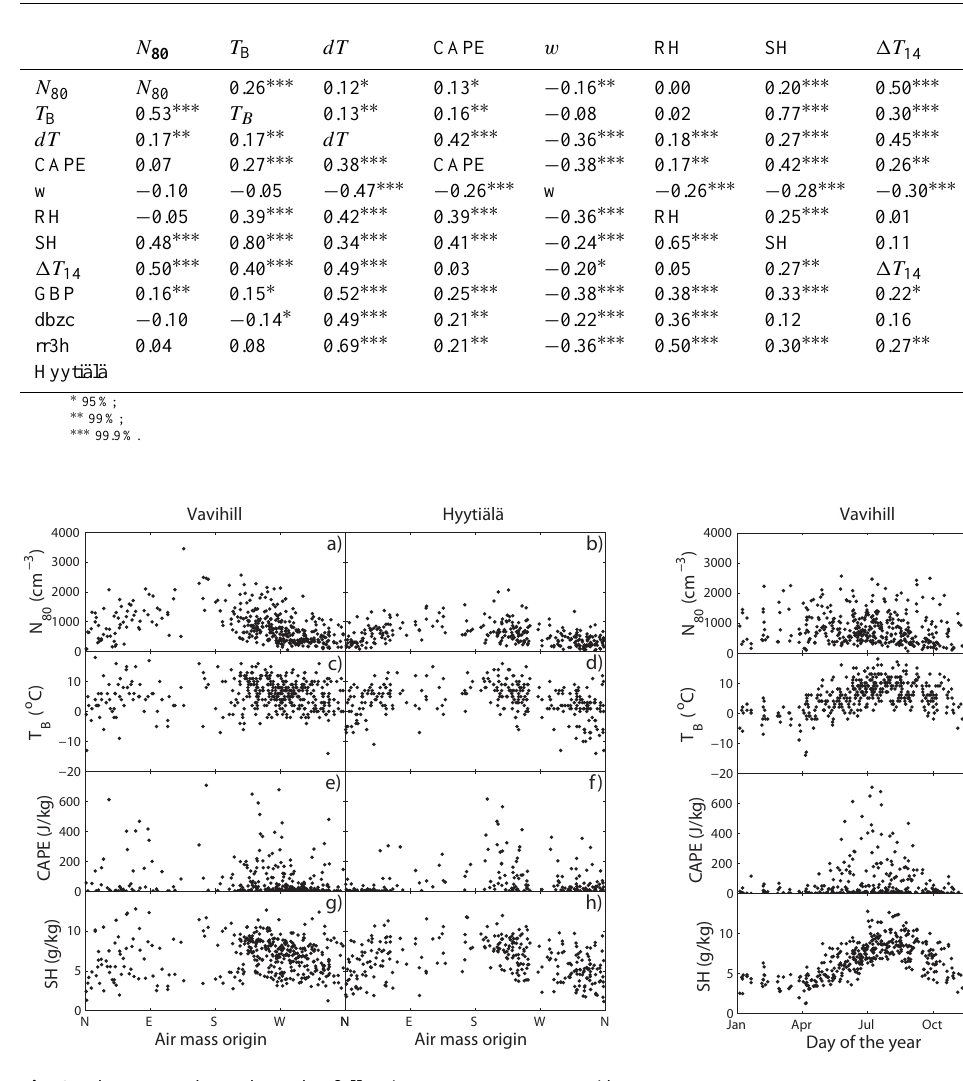
Table 4. Correlation coefficients for Vavihill (top right) and Hyytiälä (bottom left). N 80 (cm − 3 ) is the number concentration of particles with a diameter above 80nm, T B ( ◦ C) is the cloud base temperature, dT ( ◦ C) is the temperature difference between cloud base and cloud top, CAPE (Jkg − 1 ) is the convective available potential energy, w (Pas − 1 ) is the vertical wind velocity, RH (%) is the relative humidity, SH (gkg − 1 ) is the specific humidity, 1T 14 ( ◦ C) is the temperature difference between the r e profiles’ cloud base and the 14µm level, GBP (mm day − 1 ) is short for ground-based precipitation, dbzc is mean radar reflectivity factor (dBZ) and rr3h is the accumulated precipitation between over a 3 hour interval retrieved from weather radars (mm). The stars indicate at what confidence interval the correlation coefficients are significant.